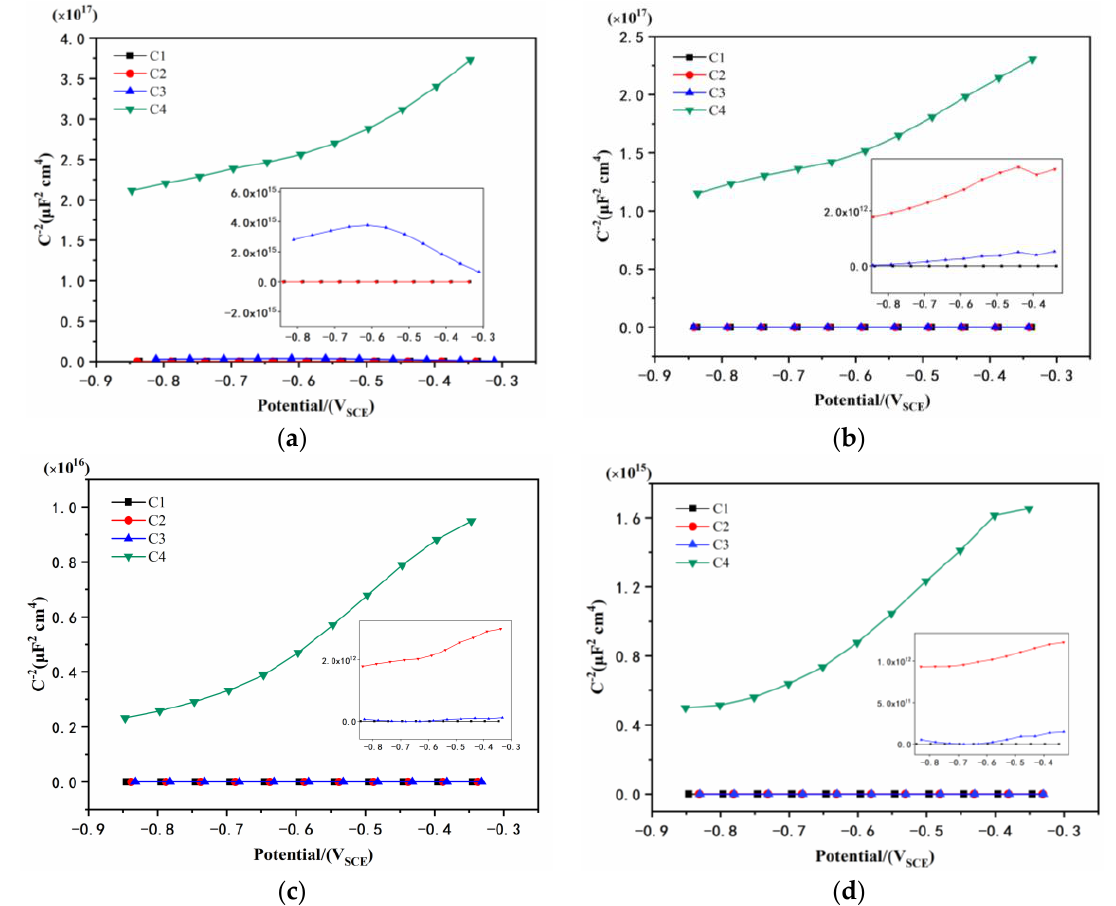
Figure 10 . Mott – Schottky curves: ( a ) 1 d, ( b ) 11 d, ( c ) 21 d, and ( d ) 31 d. Figure 10. Mott–Schottky curves: ( a ) 1 d, ( b ) 11 d, ( c ) 21 d, and ( d ) 31